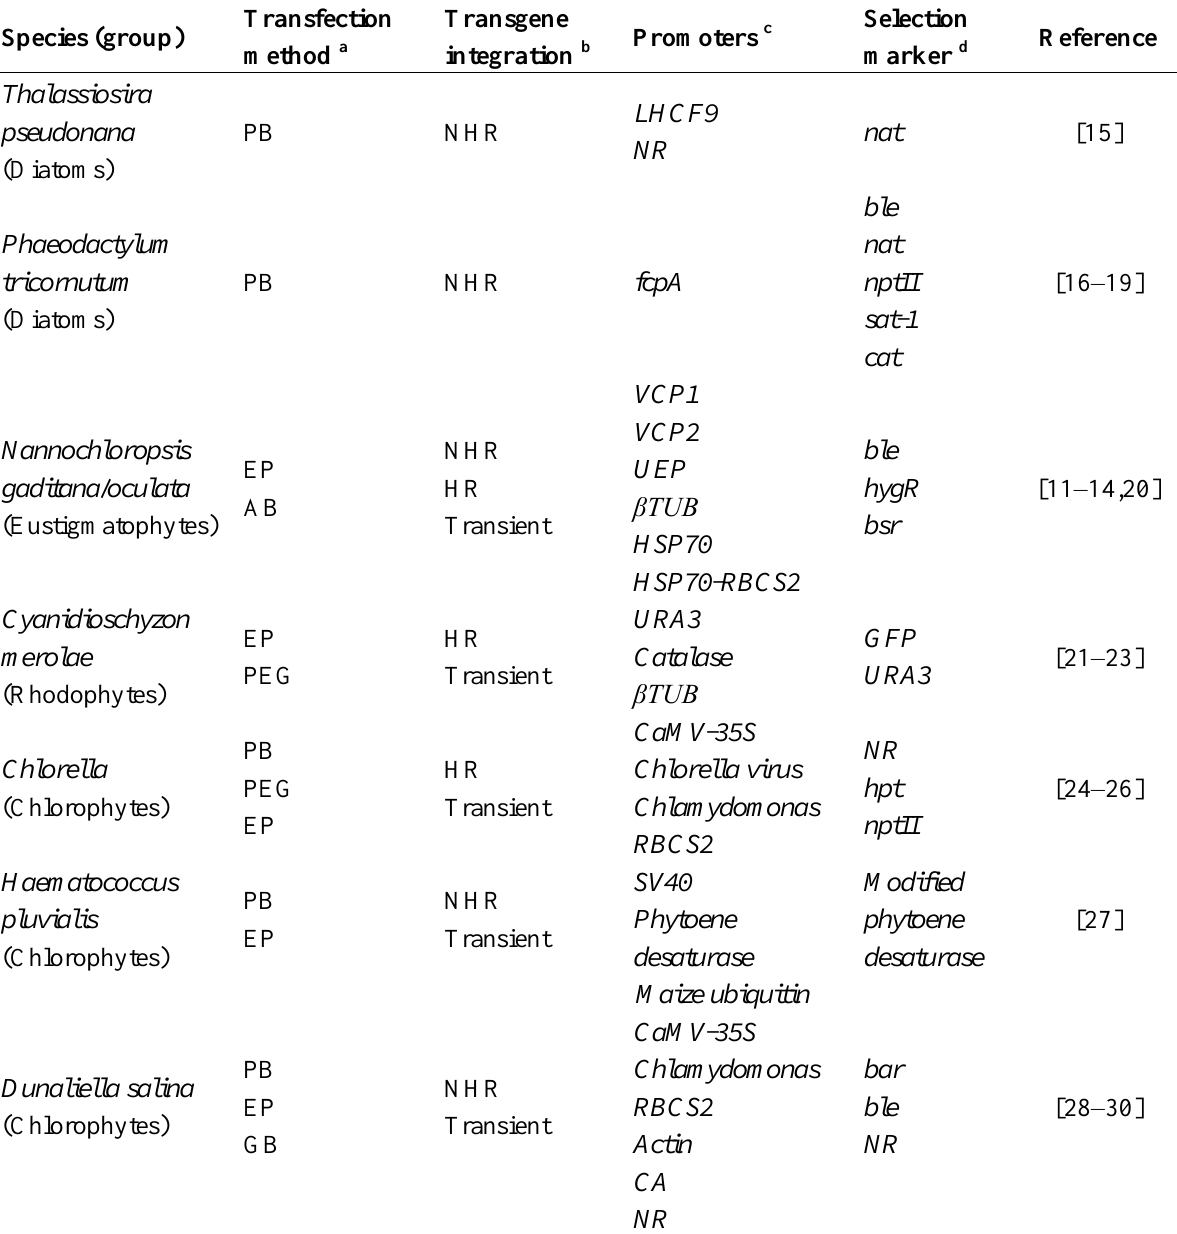
Table 1. Overview of genetically amenable microalgal